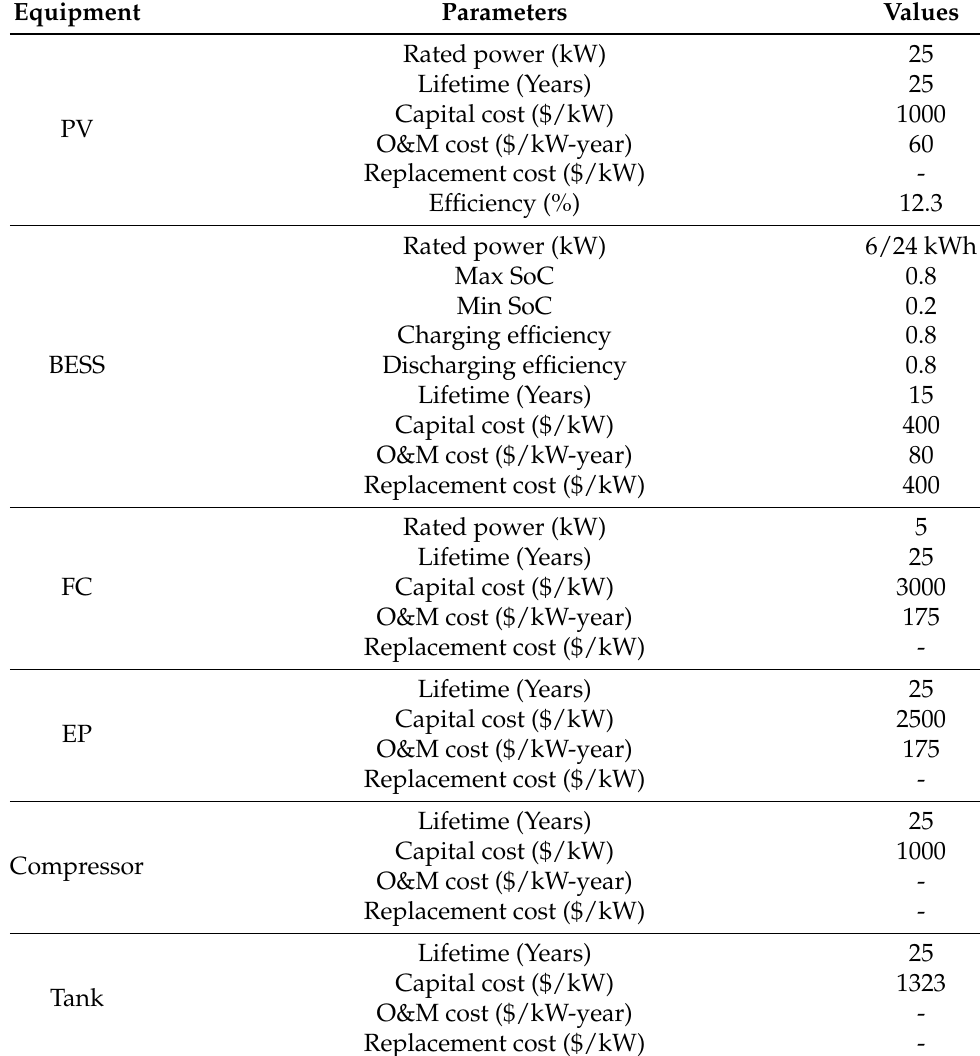
Table 10. Parameters of installed components